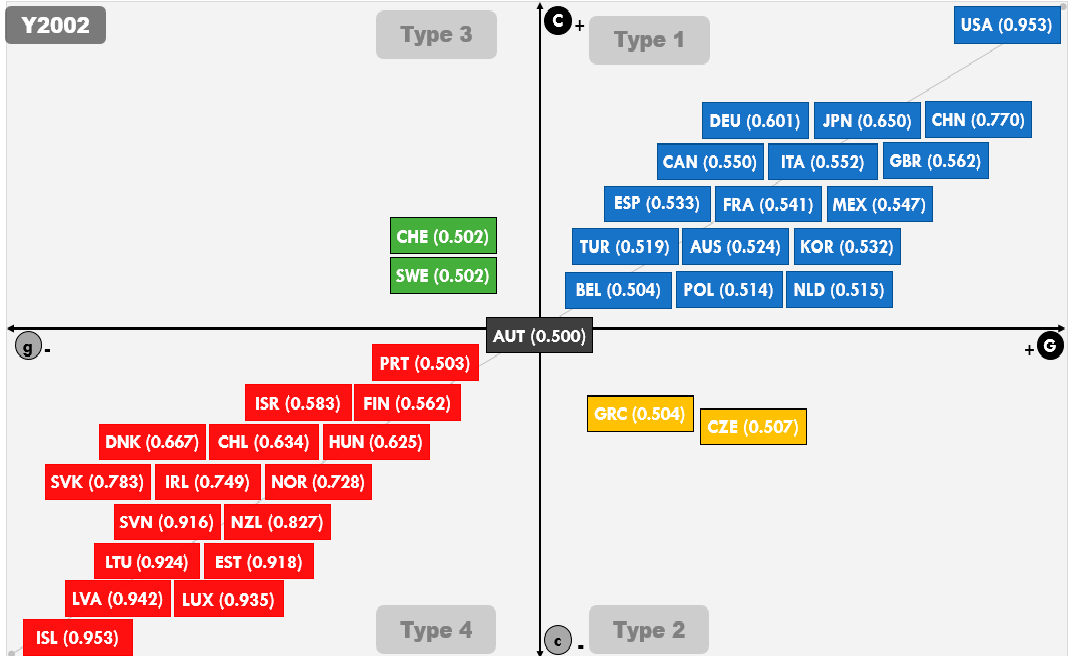
Figure 2. The Location of Link Types of the 37 Case Countries in 2002.